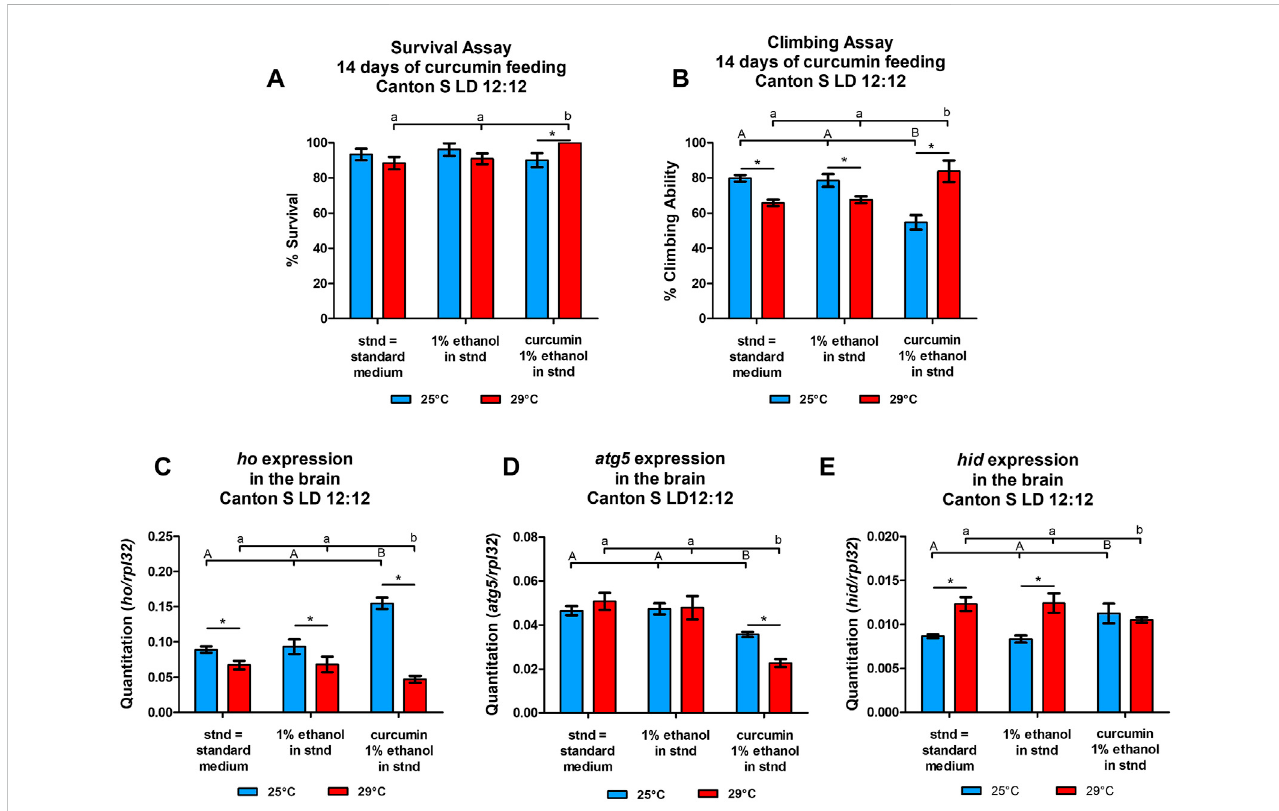
FIGURE 6 Temperature affects the survival (A) , climbing (B) (means ± SEM), and expression of heme oxygenase ( ho , (C) , autophagy-related gene 5 ( atg5 , (D) , and the cell death activator head involution defective ( hid , (E) genes (means ± SD) after chronic supplementation of curcumin for 14 ° days. Statistically signi fi cant differences between groups are indicated with different letters ( capital letters for 25 ° C and small letters for 29 ° C; non-parametric ANOVA – Kruskal Wallis and post hoc Conover-Iman tests; survival assay in 25 ° C p = 0.288, 29 ° C p = 0.046; climbing assay in 25 ° C p = 0.033, 29 ° C p = 0.025; parametric one-way ANOVA F test and Bonferroni multiple comparison test: ho mRNA level at25 ° C p < 0.0001 &at 29 ° C p < 0.0001, atg5 mRNA level at 25 ° C p < 0.0001 & at 29 ° C p < 0.0001, hid mRNA level at 25 ° C p < 0.0001 & at 29 ° C p < 0.0001) and between temperature conditions by asterisks (29 ° C vs. 25 ° C in each group; non- parametricMann-Whitneytest:survivalassay:curcumin p =0.032,1%ethanol p =0.200,andstandarddiet p =0.268;climbingassay:curcumin p =0.038,1% ethanol p = 0.050, and standard diet p = 0.050; parametric unpaired t- test with Welch ’ s correction – ho : curcumin, 1% ethanol, and standard diet p < 0.0001; atg5 : curcumin p < 0.0001, 1% ethanol p = 0.2117, standard diet p = 0.2029; hid: curcumin, 1% ethanol, and standard diet p < 0.0001). Both survival and climbing assays were repeated three times (30 fl ies in each treatment), while gene expression was studied in at least three repetitions for each treatment